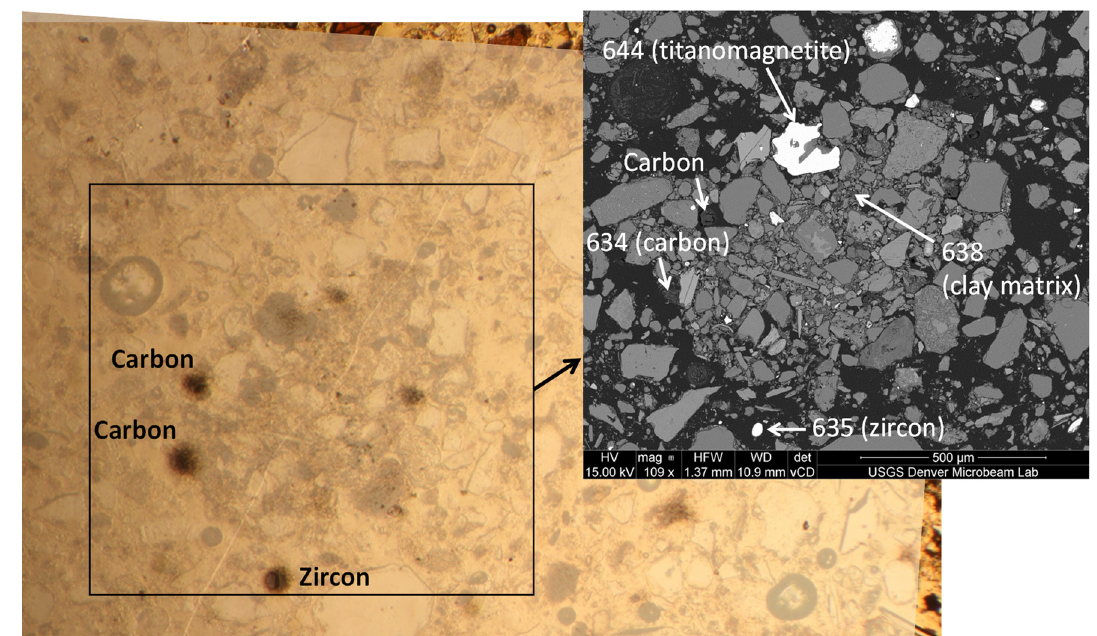
Figure 15. GJAST-14-8 area 8 (Figure 8), thin section plain light background with fission-track overlay at 25% transparency with added SEM-BSE image of clay ball with three high fission-track spots, two carbon pieces, and one zircon grain. Numbering corresponds to spectrums in Figure 16.